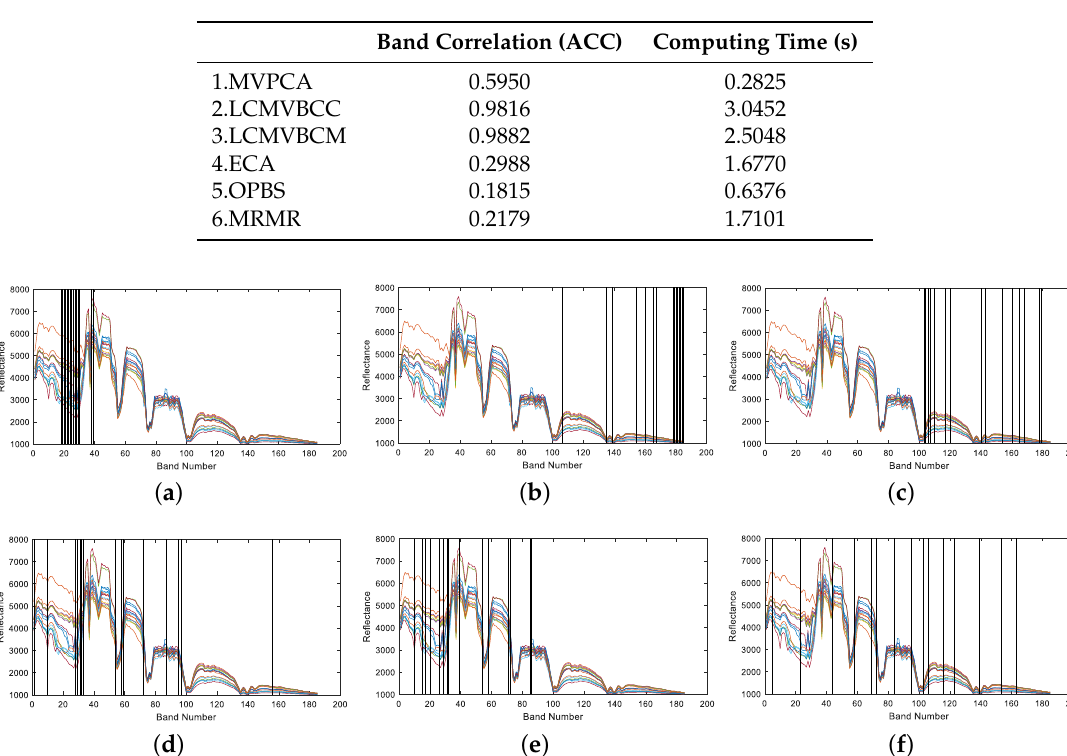
Table 2. Average band correlation and computing time for selecting fifteen bands from the Indian Pine dataset.